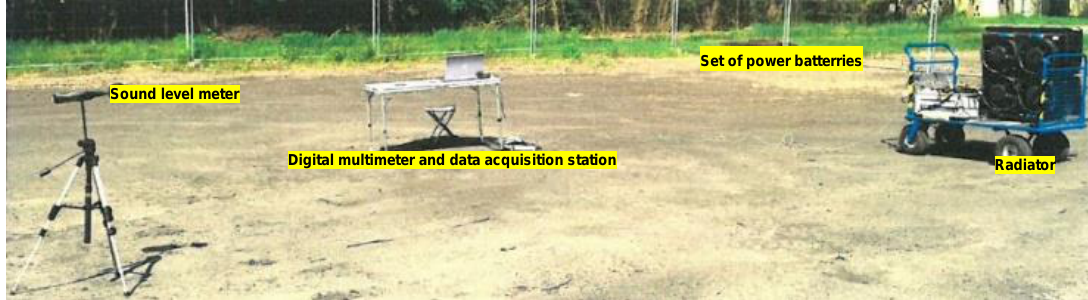
Fig. 14. The view of the test stand during the performance of acoustic pressure tests of the radiator in the field conditions at the Military Institute of Ar- moured and Automotive Technology (test certificate 41/LPE/2020)